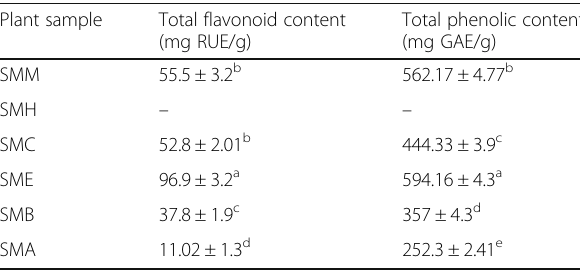
Table 1 Total flavonoid and phenolic contents and other metabolites in stem bark of S. mukorossi Plant